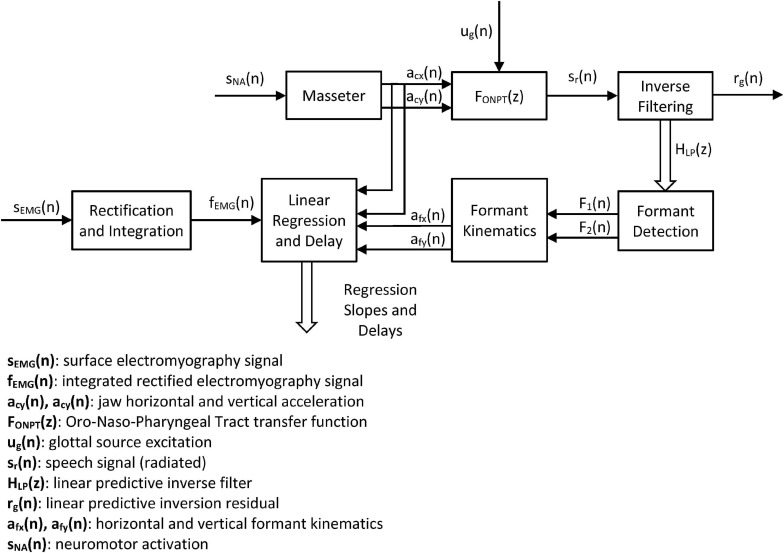
Systemic view of the study. The neuromotor activity induced in the masseter sNA(n) produces accelerations in the horizontal and vertical directions of the jaw-tongue structure on the sagittal plane [acx(n) and acy(n)] which may be directly estimated from the 3D accelerometer. The dynamic action on this structure changes the configuration of the ONPT, and its filtering function FONPT(z). The radiated speech signal sr(n) is the result of filtering the glottal excitation ug(n) by the ONPT. The inverse filtering of speech reconstructs the inverse transfer function HLP(z), which is used to determine the first two formants F1(n) and F2(n). The dynamic behavior of the first two formants is used to indirectly estimate the correlates of the horizontal and vertical accelerations in the sagittal plane afx(n) and afy(n). Cross-correlation between dynamic and acoustic estimations of acceleration and force from sEMG measurements is used to optimally align formants and accelerations. Linear regression between dynamic and acoustic variables is used to estimate the model weights.